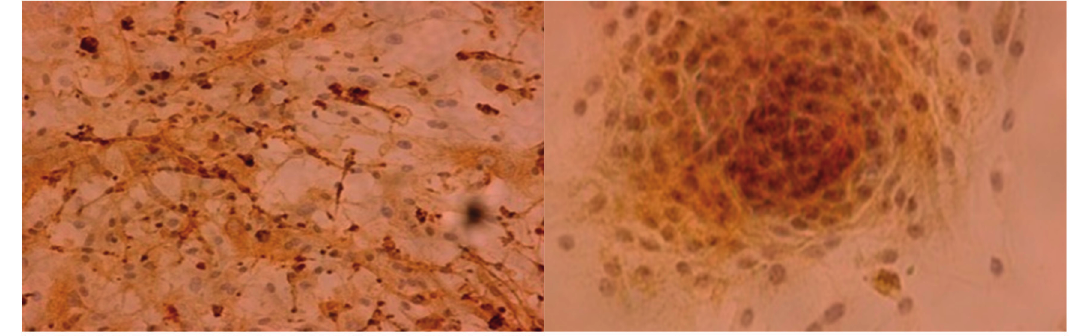
Figure 1. Samples of epithelial membrane antigen (EMA) expression in primary meningioma cell lines; magnification ×200-fold.